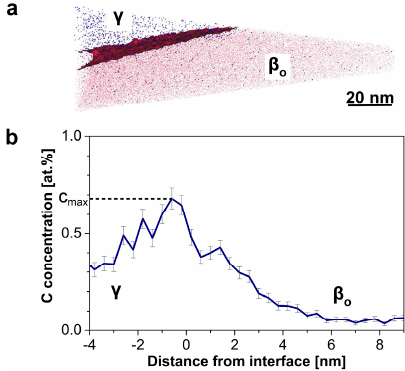
Figure 8. ( a ) APT reconstruction of a TNM0.75C specimen containing a β o / γ interface; and ( b ) C proximity histogram across this interface. ( a ) A clearly inhomogeneous distribution of the alloying elements Mo (red) and C (blue) across the interface is visible. The interface indicated corresponds to a Mo isoconcentration surface, which shows the most pronounced concentration gradient. The histogram in ( b ) evidences significant segregation of C to the β o / γ interface, with a local maximum C concentration of ≈ 0.7 at%. (Reprinted with permission from [22], Copyright© 2015, Elsevier).